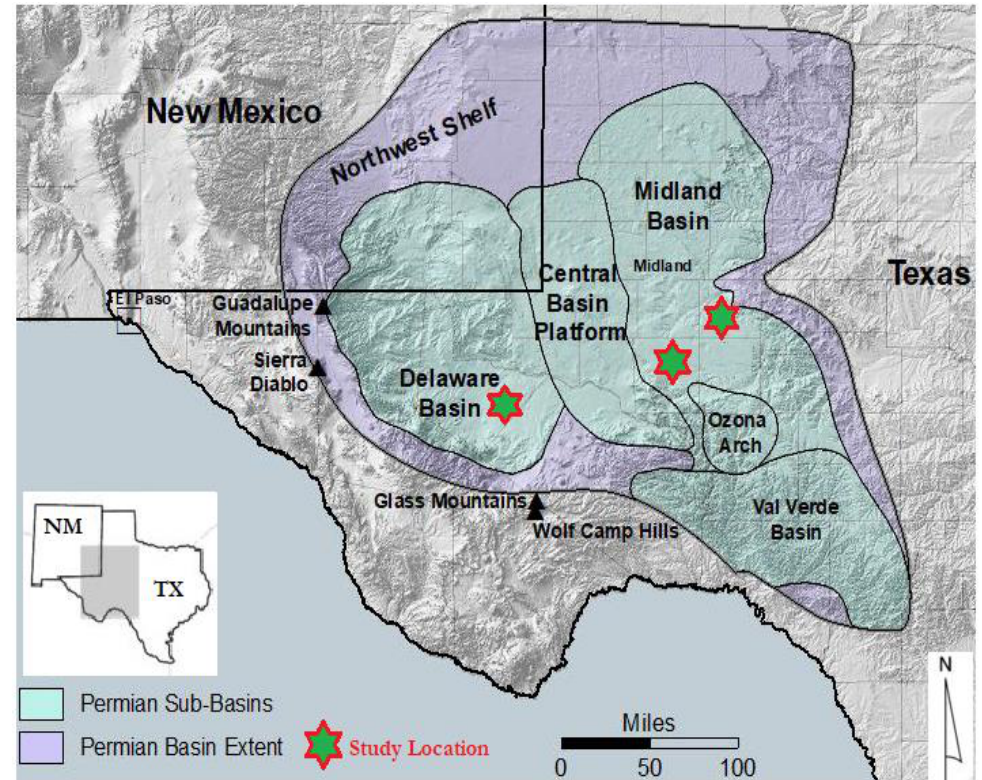
Figure 1. The geographic region of the Permian Basin, West Texas. The study area is in the Reeves county of Delaware Basin, and wells from Upton and Glasscock counties of Midland Basin (green-red star). Midland and Delaware basin stratigraphy is adapted from Ramiro-Ramirez et al. [50].